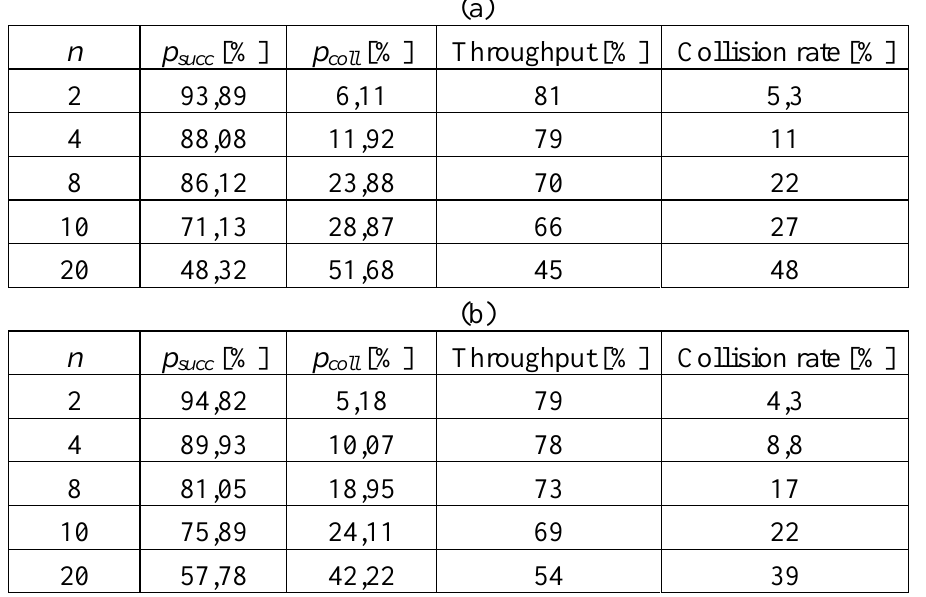
Table 1 . Saturation performance of predictive p -CSMA for the scenario 1 (a) and the scenario 2